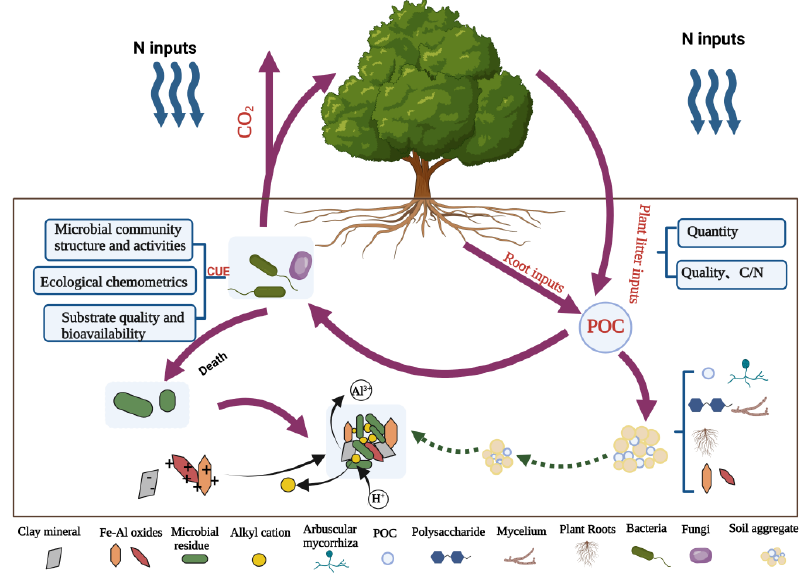
Figure 1. Effect of nitrogen on POC and MAOC cycle processes.